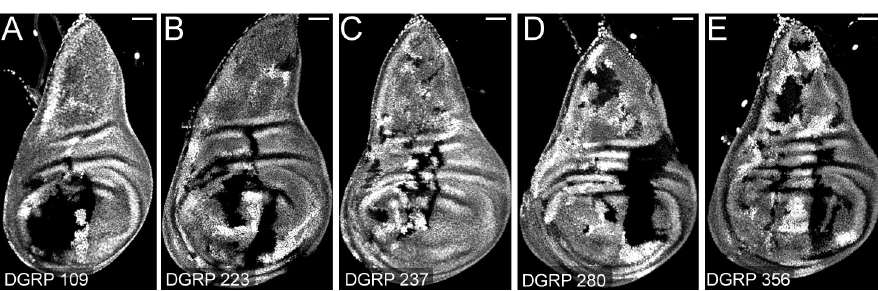
Fig 5. MAGIC generates clones with DGRP lines. (A–E) Clones in wing imaginal discs by pairing gRNA-40D2(BFP); hh-Cas9 with DGRP line 109 (A), 223 (B), 237 (C), 280 (D), and 356 (E). Scale bars, 50 μ m. DGRP, Drosophila Genetic Reference Panel; MAGIC, mosaic analysis by gRNA-induced crossing-over.